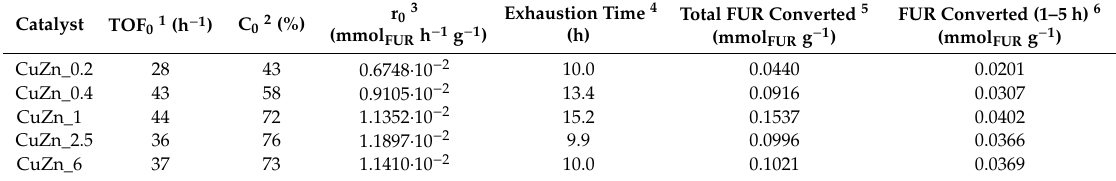
Table 5. Turnover frequency and lifetime analysis of CuZn_X catalysts, obtained from linearization of Figure 10.